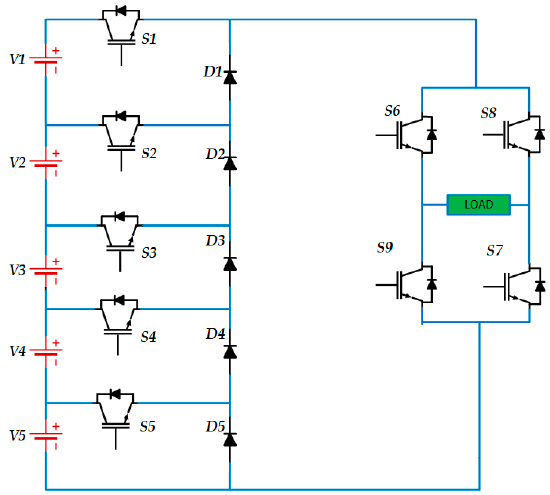
Figure 6. 11 − Level MLI.